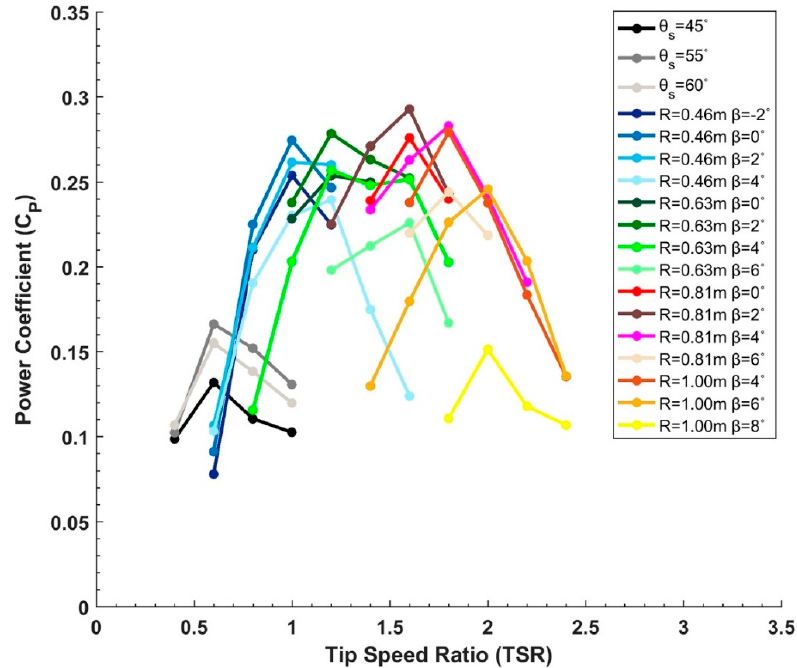
Figure 5. Power coe ffi cient curves for the Savonius configurations with di ff erent θ s , and the Darrieus Figure 5. Power coefficient curves for the Savonius configurations with different θ s , and the Darrieus configurations with di ff erent R and β (Re = 145,132). configurations with different R and β (Re = 145,132 ) .